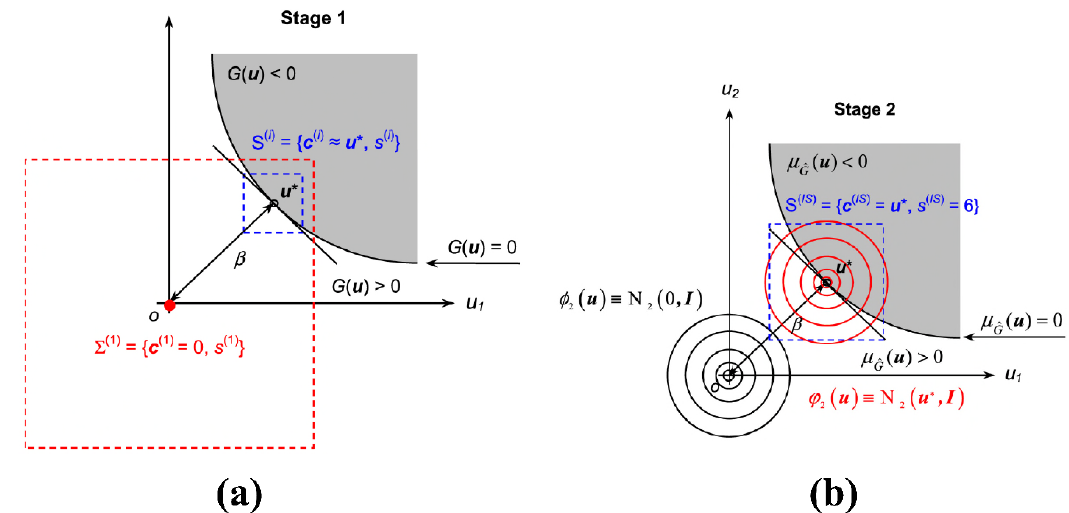
Figure 6. Reliability assessment problem in the standard Gaussian space with the two stages involved in a proposed adaptive Kriging SM: ( a ) stage 1 for design point search and POF prediction based on FORM with the adaptive Kriging-based, trust-region method; ( b ) stage 2 for the POF prediction based on MCS-IS with the Kriging model defined iteratively around the FORM design point with the active refinement algorithm of the AK-MCS method [55]. Reprinted with permission from [55]. Copyright 2020, Elsevier.